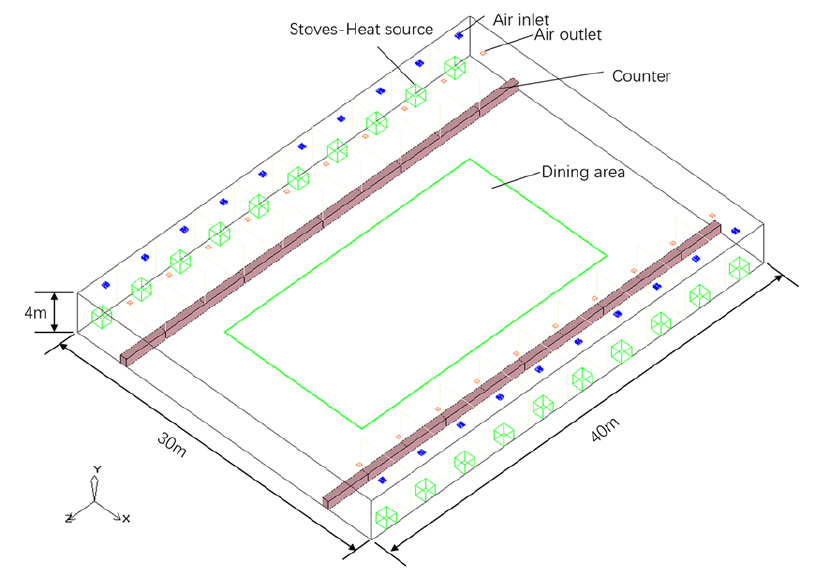
Figure 2. Physical model of the catering area.